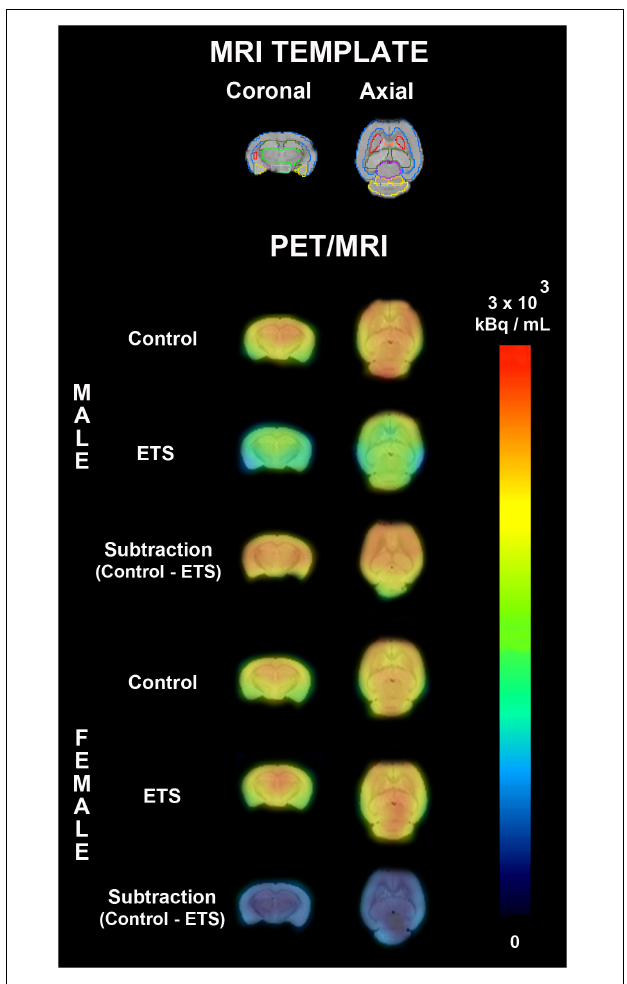
FIGURE 4 | PET average images of female and male adult mice exposed to ETS during the early postnatal period and the control group. On the top, a MRI template used for drawing volumes of interest (whole brain, brainstem, cortex, cerebellum, left amygdala, right amygdala, left striatum, right striatum, left hippocampus, right hippocampus, cingulate cortex, basal forebrain and septum, thalamus, hypothalamus, left midbrain, and right midbrain). The first two rows represent PET average images fused to MRI template and the third row represent the difference of PET average image fused to MRI template between control group and ETS exposed